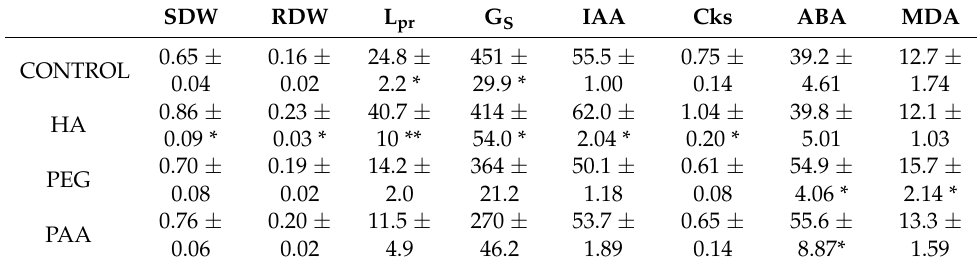
Table 2. Biomarkers content for different treatments applied.